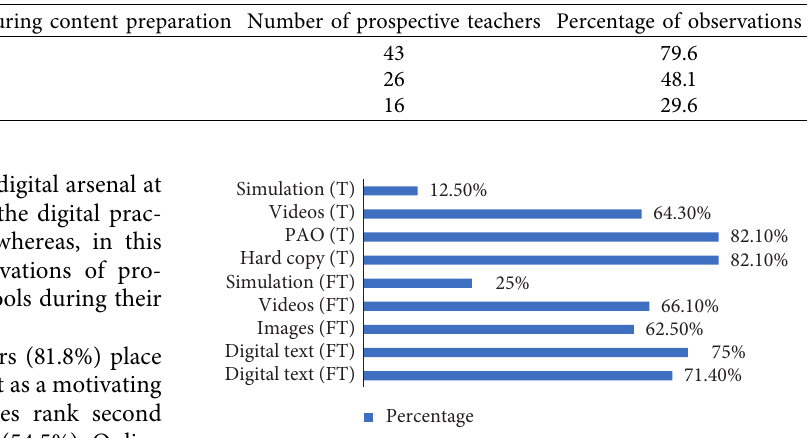
Figure 3: The types of trainer’s outputs and prospective teachers during training. T: trainers, FT: prospective